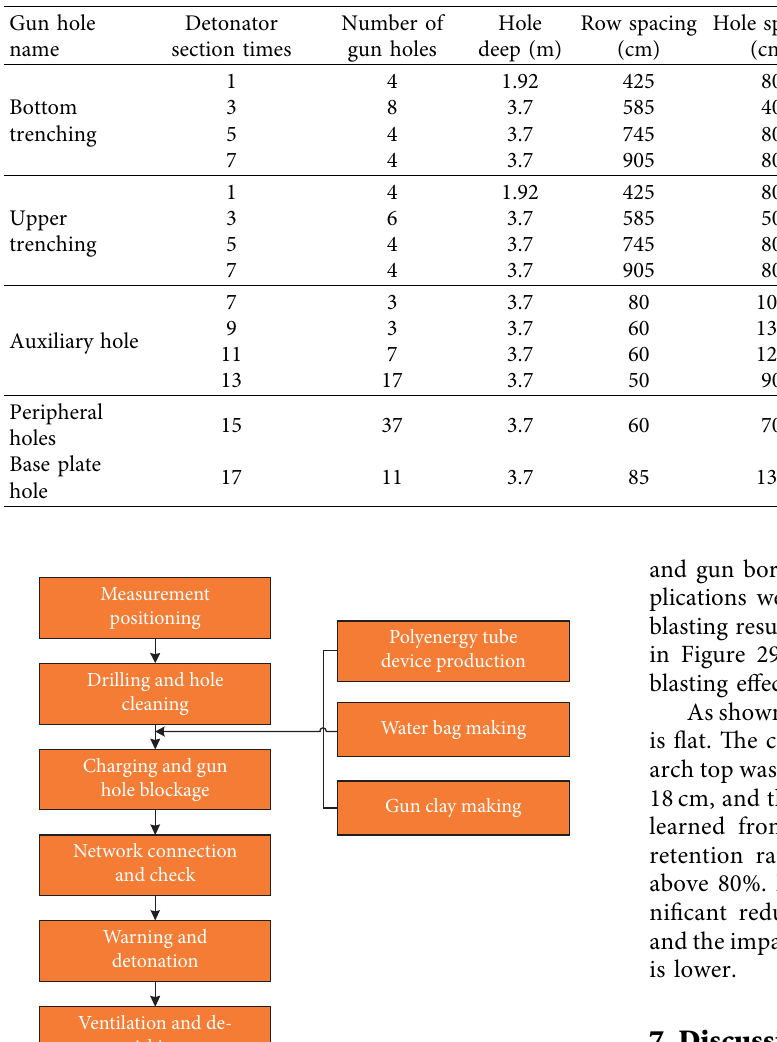
Figure 27: Detonation network diagram of step blasting Table 6: Detailed hole layout parameters.